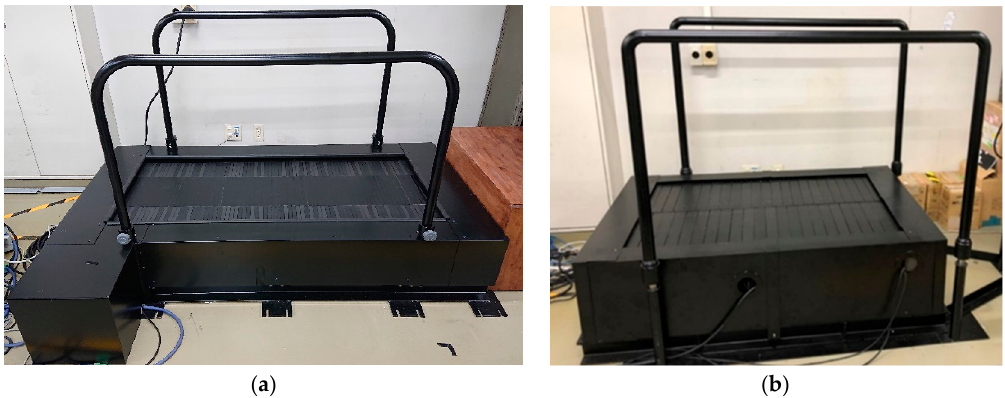
Figure 1. Two types of load-controlled treadmills: ( a ) single-belt style; ( b ) split-belt type divided into left and